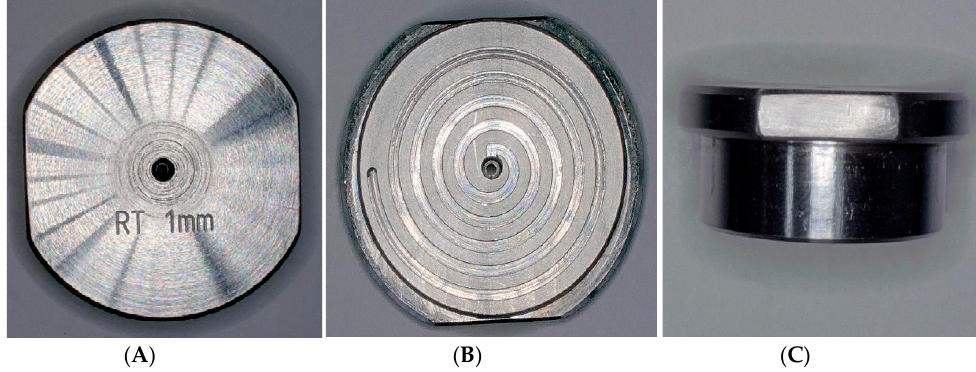
Figure 2. Changeable mould unit including a central ejector for spiral geometries with a cross section of 1 × 1 mm 2 . ( A ) Bottom view; ( B ) top view; ( C ) side view.